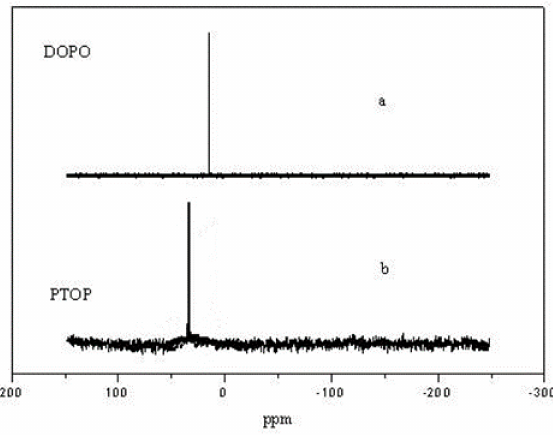
Figure 4. The 31 P NMR of DOPO and PTOP.